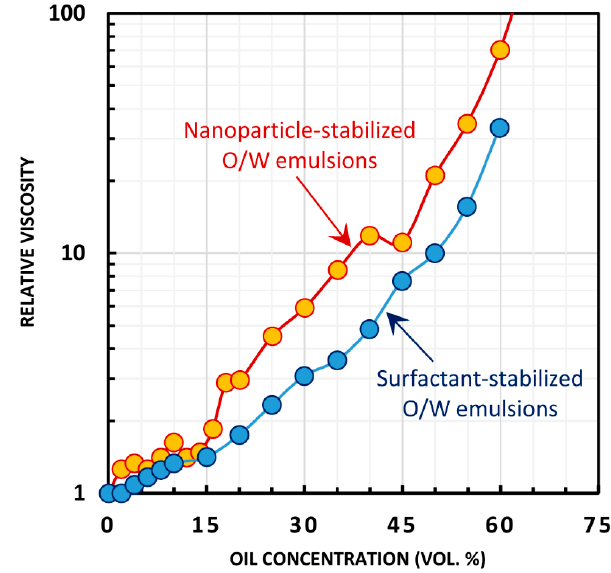
Figure 11. Comparison of the relative viscosities of Pickering emulsions and surfactant-stabilized emulsions at a fixed rpm of 30 (shear rate of 36.78 s − 1 emulsions at a fixed rpm of 30 (shear rate of 36.78 s − 1 ).